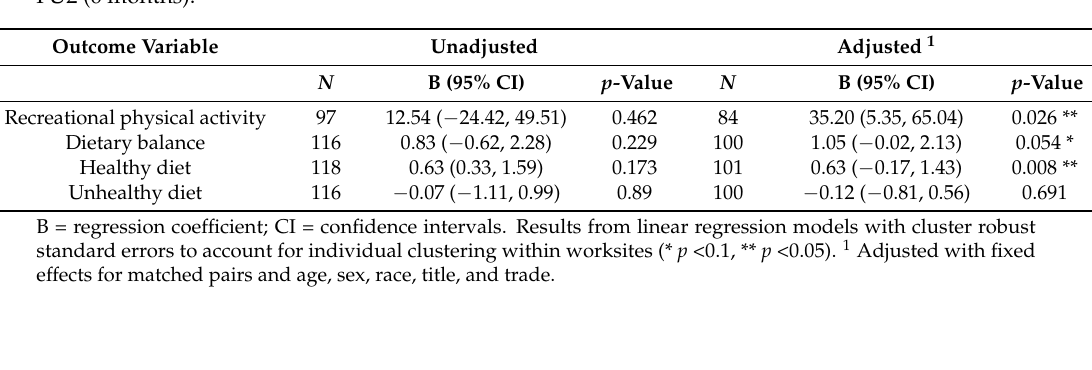
Table 4. Effects of the ARM intervention on physical activity and dietary behaviors from baseline to FU2 (6